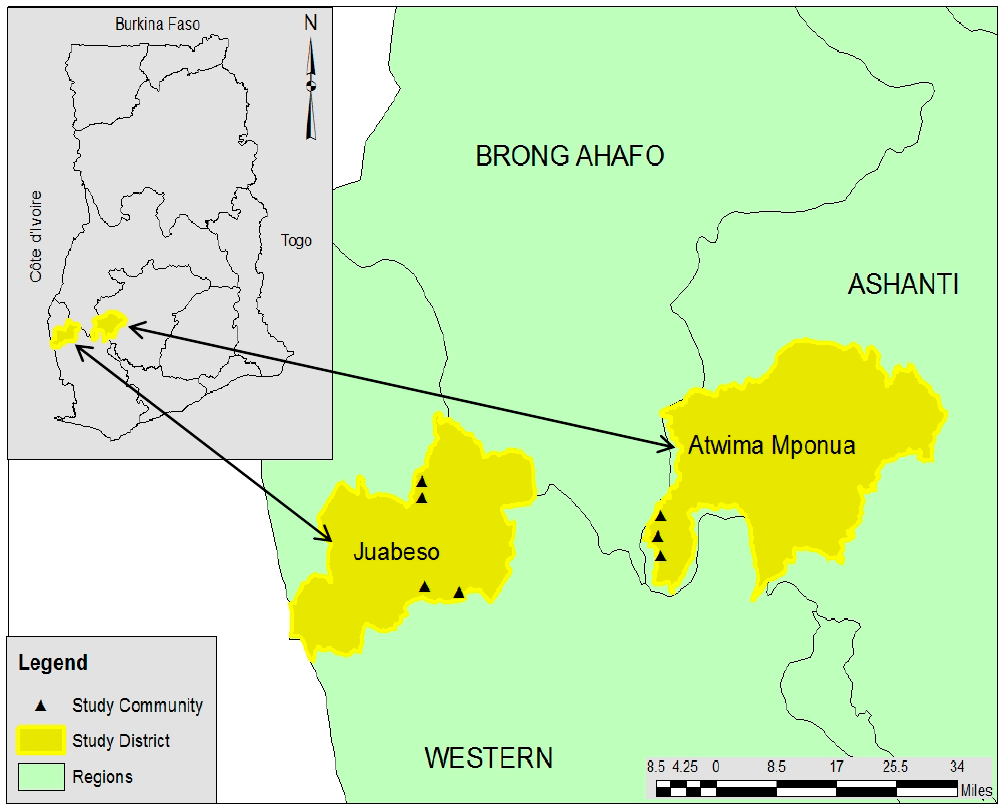
Figure 1. Map of the Study Area (Source: Authors (2015)). The Juabeso district is in the Western Region of Ghana while the Atwima Mponua district is located in the Ashanti Region. The characteristics of both regions are displayed in Table